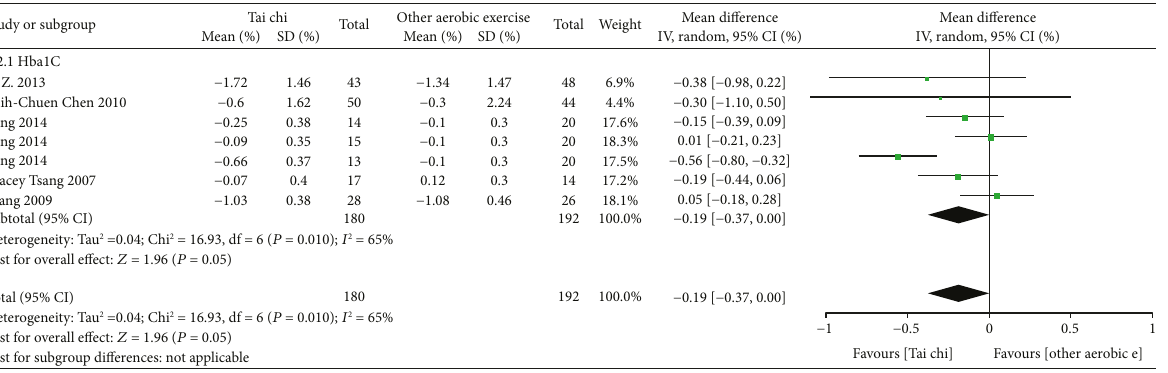
Figure 5: The meta-analysis for comparing HbA1c between Tai chi and other aerobic exercises. CI: con fi dence interval; SD: standard